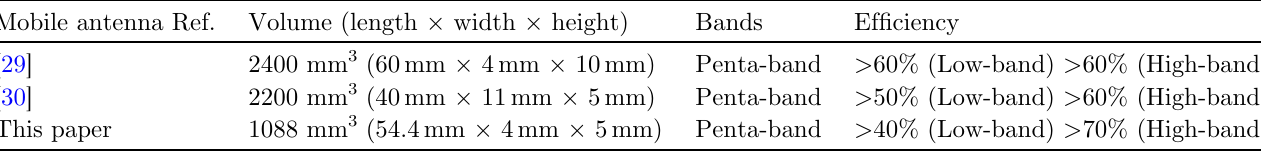
Table 2. Comparison of various mobile antenna. Mobile antenna Ref.